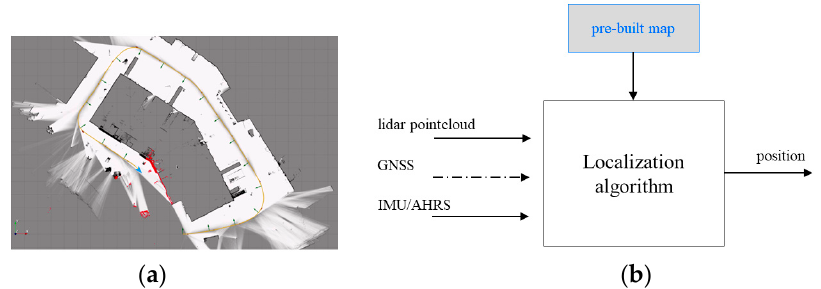
Figure 13. Lidar-based localization algorithm: ( a ) map building process and ( b ) localization operating schemes.